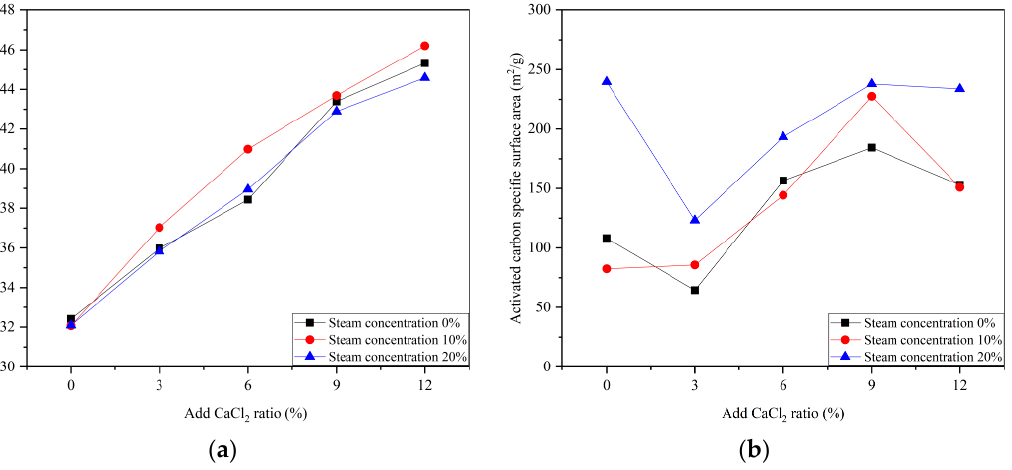
Figure 8. Variation trend of activated carbon yield and specific surface area with the addition ratio of CaCl 2 : ( a ) activated carbon yield and ( b ) activated carbon-specific surface area.